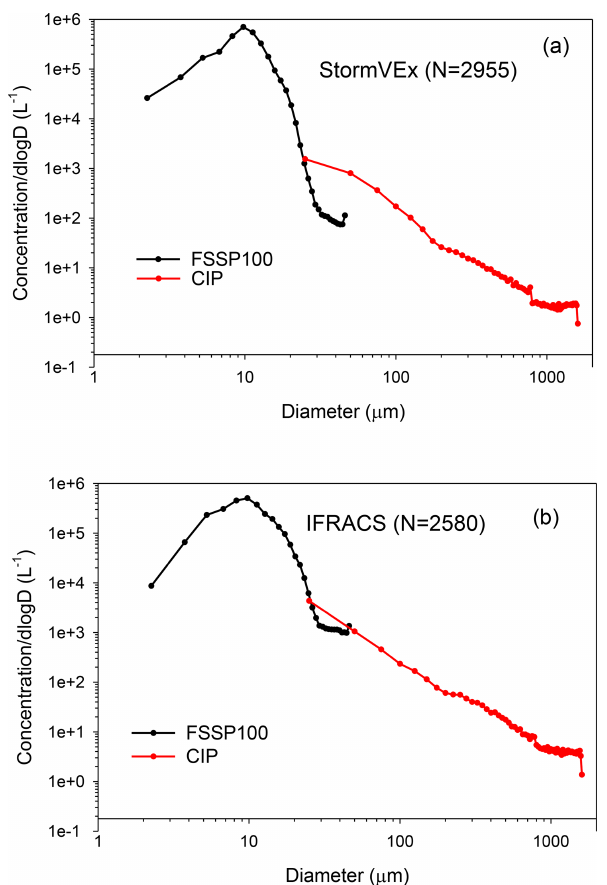
Figure 2. Average of concurrent 1min FSSP-100 and CIP particle size distributions (PSDs) from StormVEx (a) and IFRACS (b)